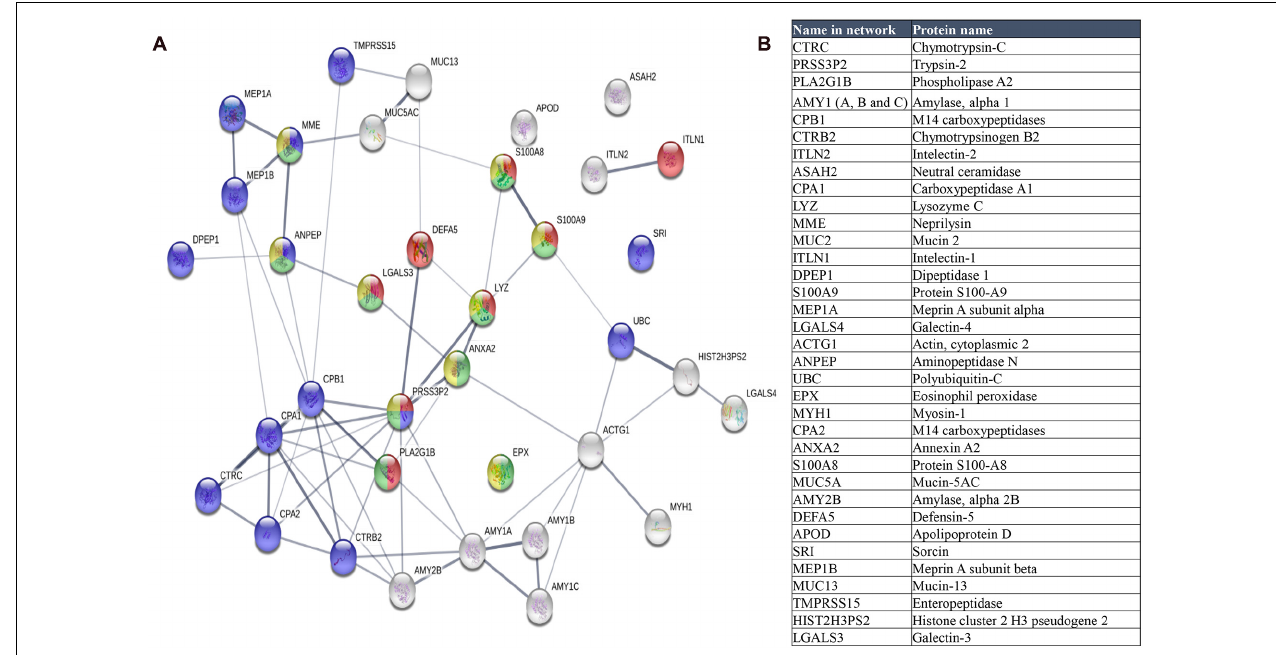
FIGURE 9 | (A) STRING map protein-protein interaction network of the 35 more abundant human proteins identified in this study. Line thickness indicates the strength of data support. The colors represent different processes; red: antimicrobial humoral response, green: neutrophil mediated immunity, blue: proteolysis and yellow: neutrophil degranulation. (B) Table of these proteins ordered according to decreasing